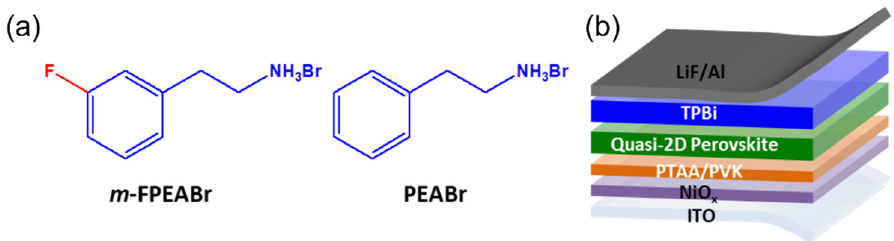
Figure 1. ( a ) Molecular structures of m -FPEABr and PEABr; ( b ) Schematic diagram of device structure of perovskite light-emitting diodes (PeLEDs).